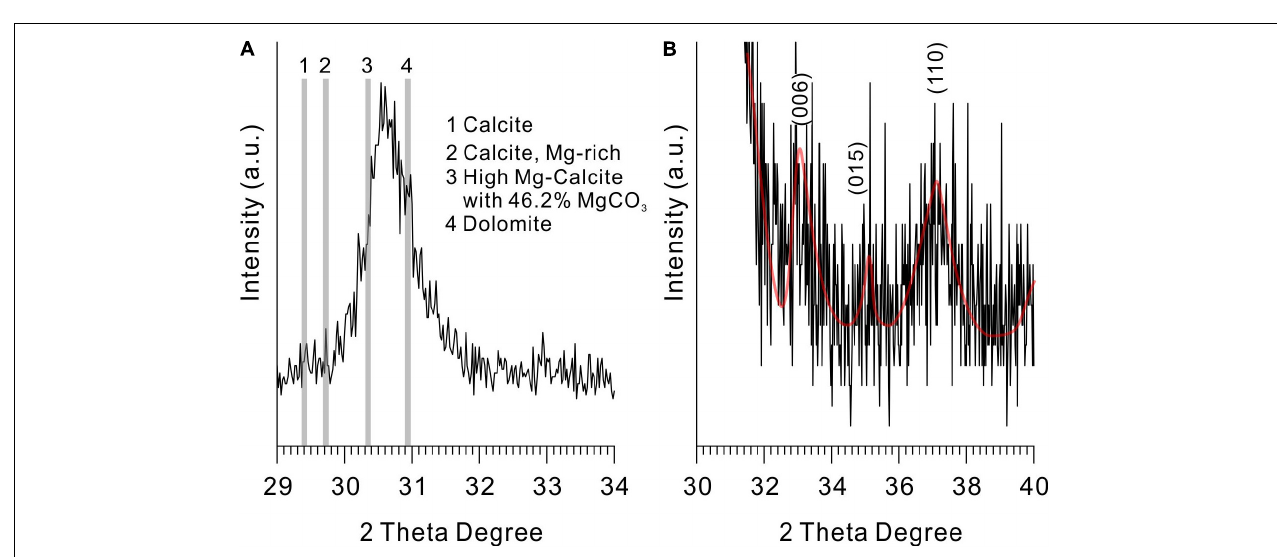
FIGURE 4 | X-ray diffraction (XRD) patterns of the minerals induced by Vibrio harveyi QPL2 and the precipitates in the abiotic control experiments. (A–E) Minerals induced by QPL2 in the mediums with Mg/Ca molar ratios of 0, 3, 6, 10, and 12. (F–J) Minerals in the abiotic experiments with Mg/Ca molar ratios of 0, 3, 6, 10, and 12. (K) Protodolomite synthesized in pure inorganic solution at 60 ◦ C.